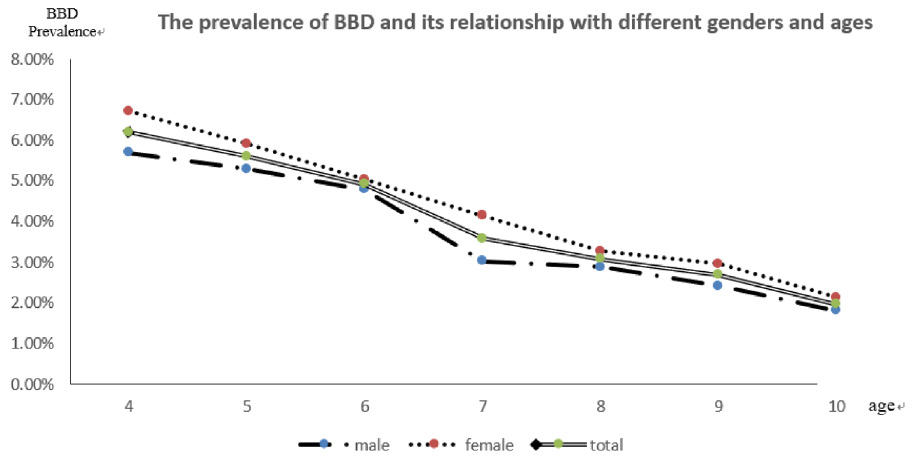
Figure 3. The prevalence of BBD according to gender and